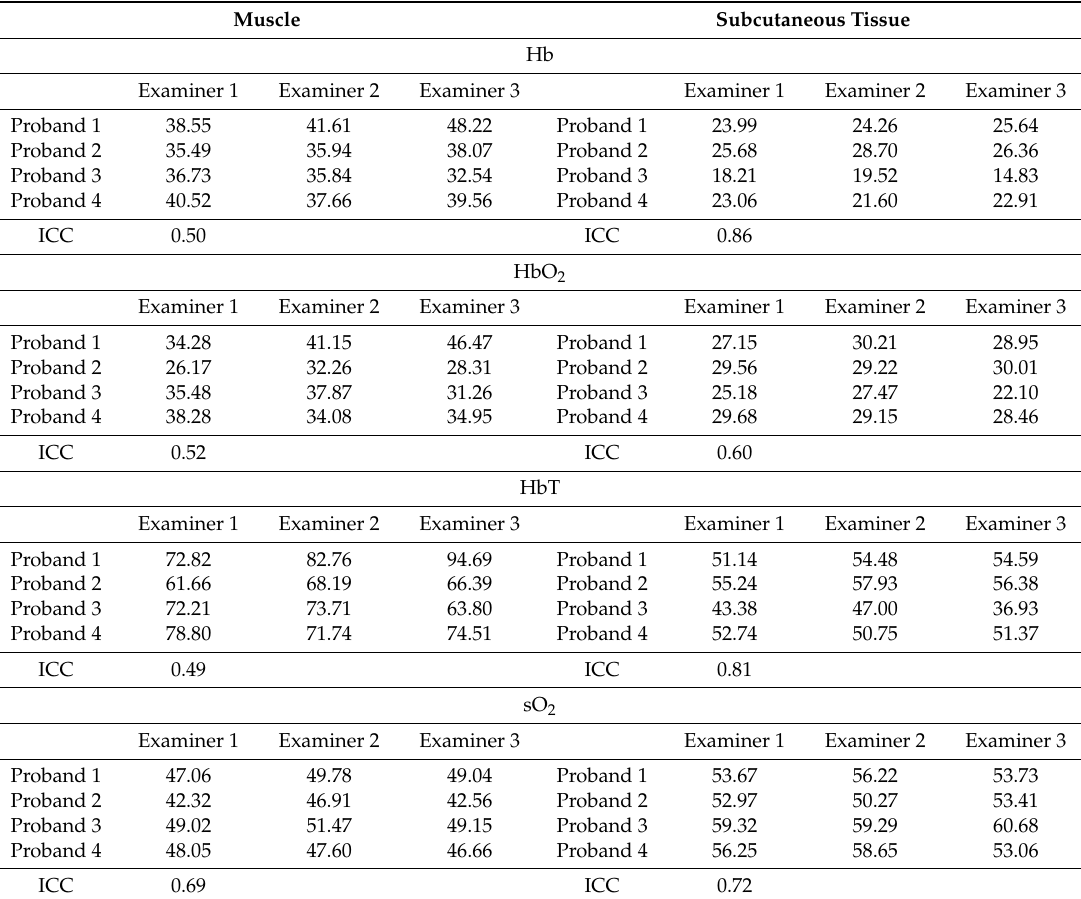
Table 3. Interclass correlation coefficients (ICC) calculated from mean values for Hb, HbO 2 , HbT and sO 2 (a.u.) for four healthy volunteers investigated by three different examiners each. ICCs from 0.41 to 0.60 were considered to correspond with moderate, from 0.61 to 0.80 with substantial/good and from 0.81 to 1.00 with excellent